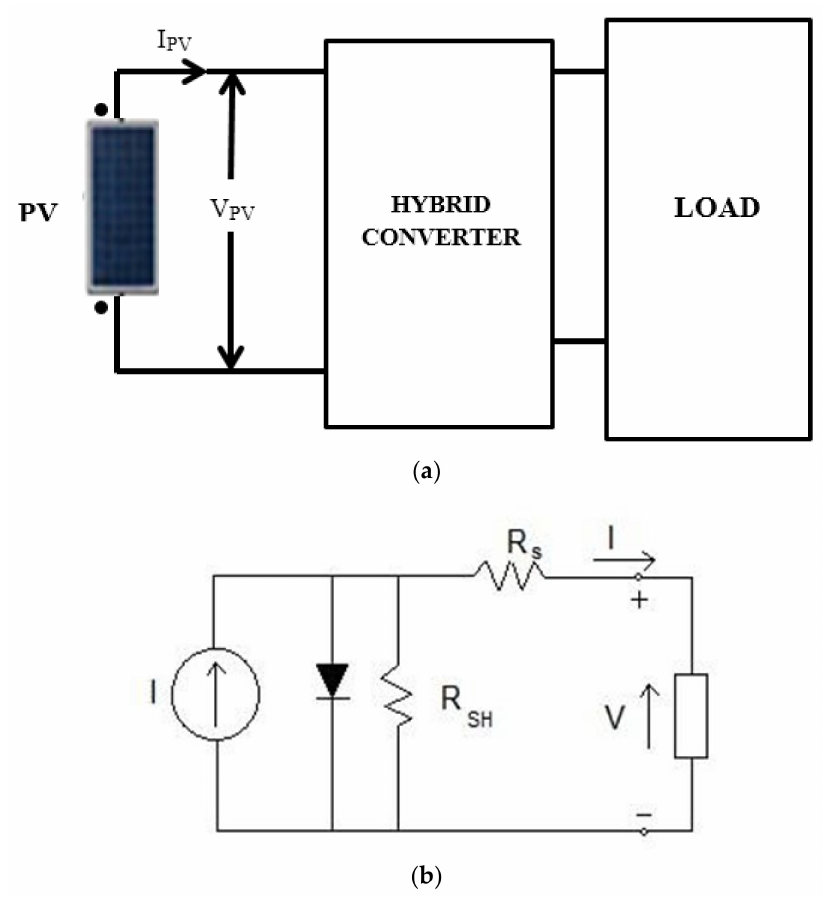
Figure 1. ( a ) Schematic diagram of a proposed module. ( b ) Diode model of a PV